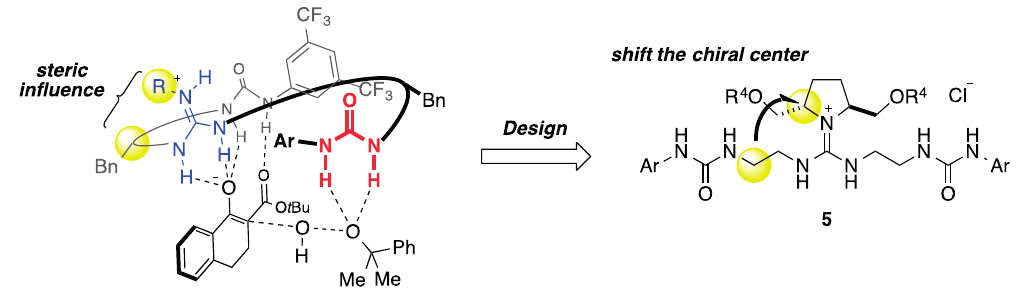
Figure 2. Design of our chiral pyrrolidine-derived guanidine-bisurea bifunctional organocatalysts 5